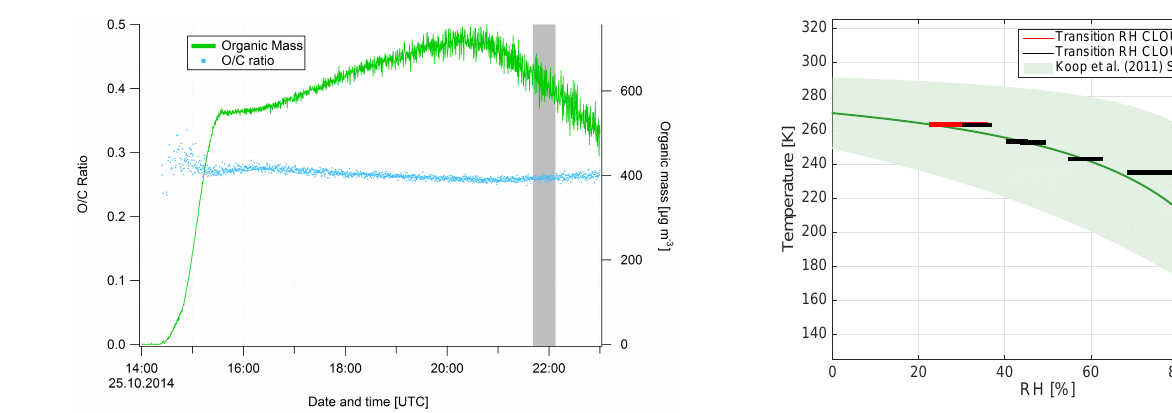
Figure 10. SOA mass concentration (green trace) and O / C ratio of the SOA particles (blue points) measured with the HR-ToF-AMS for RUN1_-10C. The grey highlighted area represents the phase transition. The mass concentration represents SOA formed via α - pinene ozonolysis; ozone was first added to the chamber during the period of steep growth at the beginning of the experiment. The de- crease in SOA concentration towards the end of the experiment was due to dilution. The O / C ratio stayed almost constant throughout the experiment.